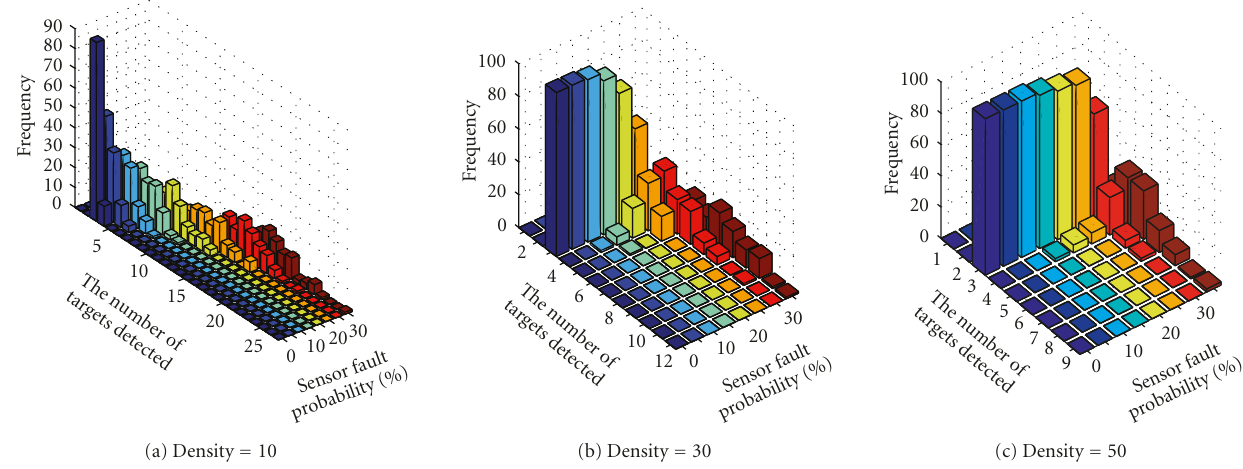
Figure 1: The number of targets detected when three targets are deployed. Here, T = 1 and density = 10,30,50, respectively.